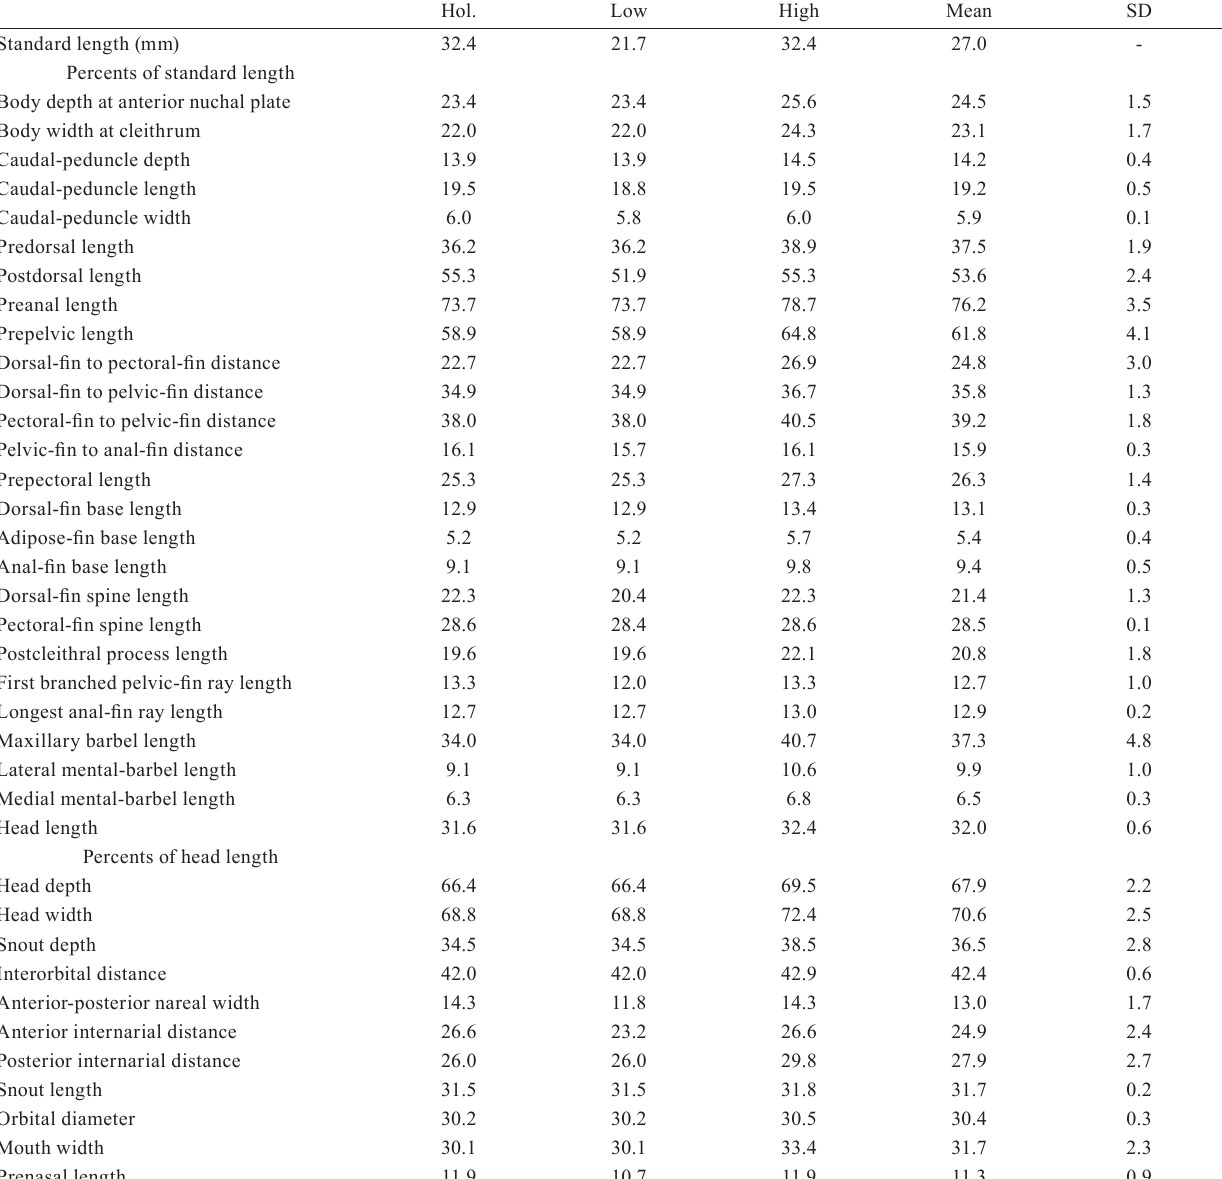
Table 1. Morphometric data for Tatia melanoleuca . Hol.=holotype; range includes holotype and one paratype. SD= standard